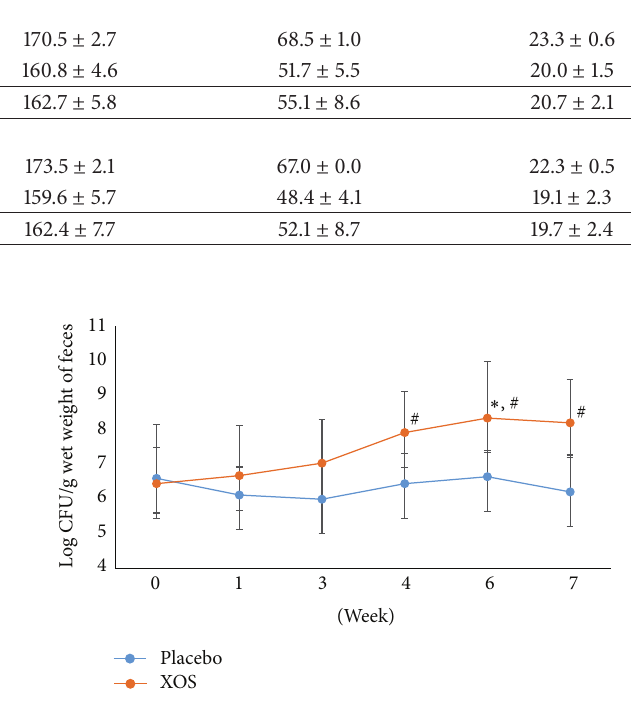
Figure 3: The changes in logarithm number (mean ± SD) of Lactobacillus spp . during the trial. Weeks 0-1: a run-in phase. Weeks 6-7: a 1-week washout phase. # Repeated measures ANOVA on different groups across time. ∗ Paired t -test of week 6 versus week 0 within a group. 𝑝 < 0.05